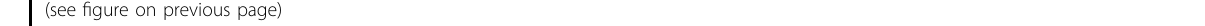
Fig. 8 LJ-2698 inhibited renal lipid accumulation in db/db mice. ( a ) Renal lipids were detected by ORO staining and ( b ) quanti fi ed using Image- Pro Plus 4.5 software. The scale bar indicates 20 μ m; the original magni fi cation was 200 × . ( c , d ) Protein expression of PGC1 α was detected by immunoblotting. Transcription factors interacting with PGC1 α were observed, including ( e ) PPAR α protein and ( f ) NRF1 mRNA. Mitochondrial transcripts were indicated by ( g ) TFAM mRNA. Oxidative phosphorylation was represented by ( h , i ) protein expression of Cox4i1 and ( j ) Cytb mRNA. ( k ) CPT1 α and ( l ) MCAD mRNAs were analyzed to examine fatty acid β -oxidation. Data are presented as the mean ± SE of 7 – 10 mice/group.